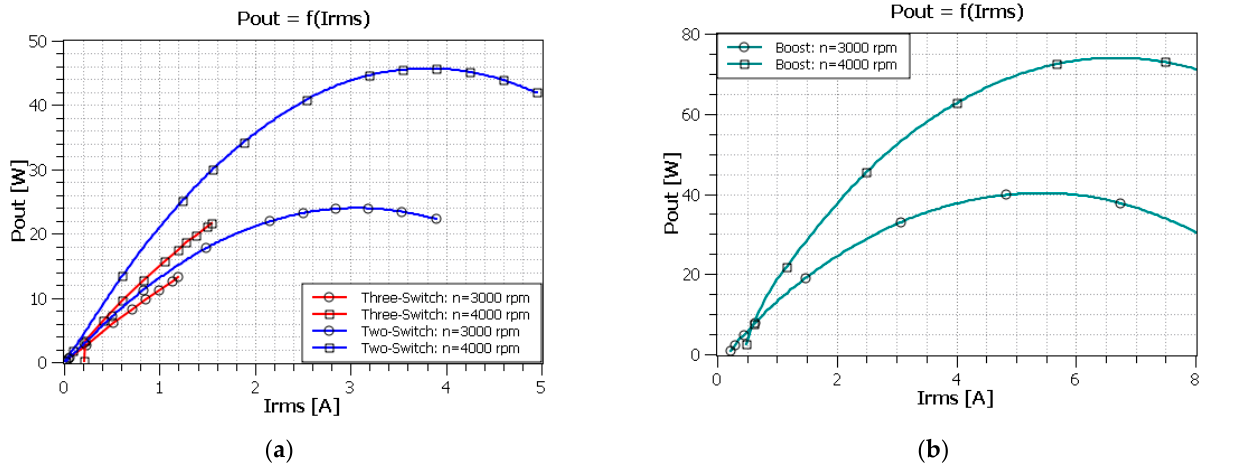
Figure 8. Converter output power as a function of the generator rms phase current value: ( a ) two-switch and three-switch converter, and ( b ) full bridge rectifier with the boost converter.